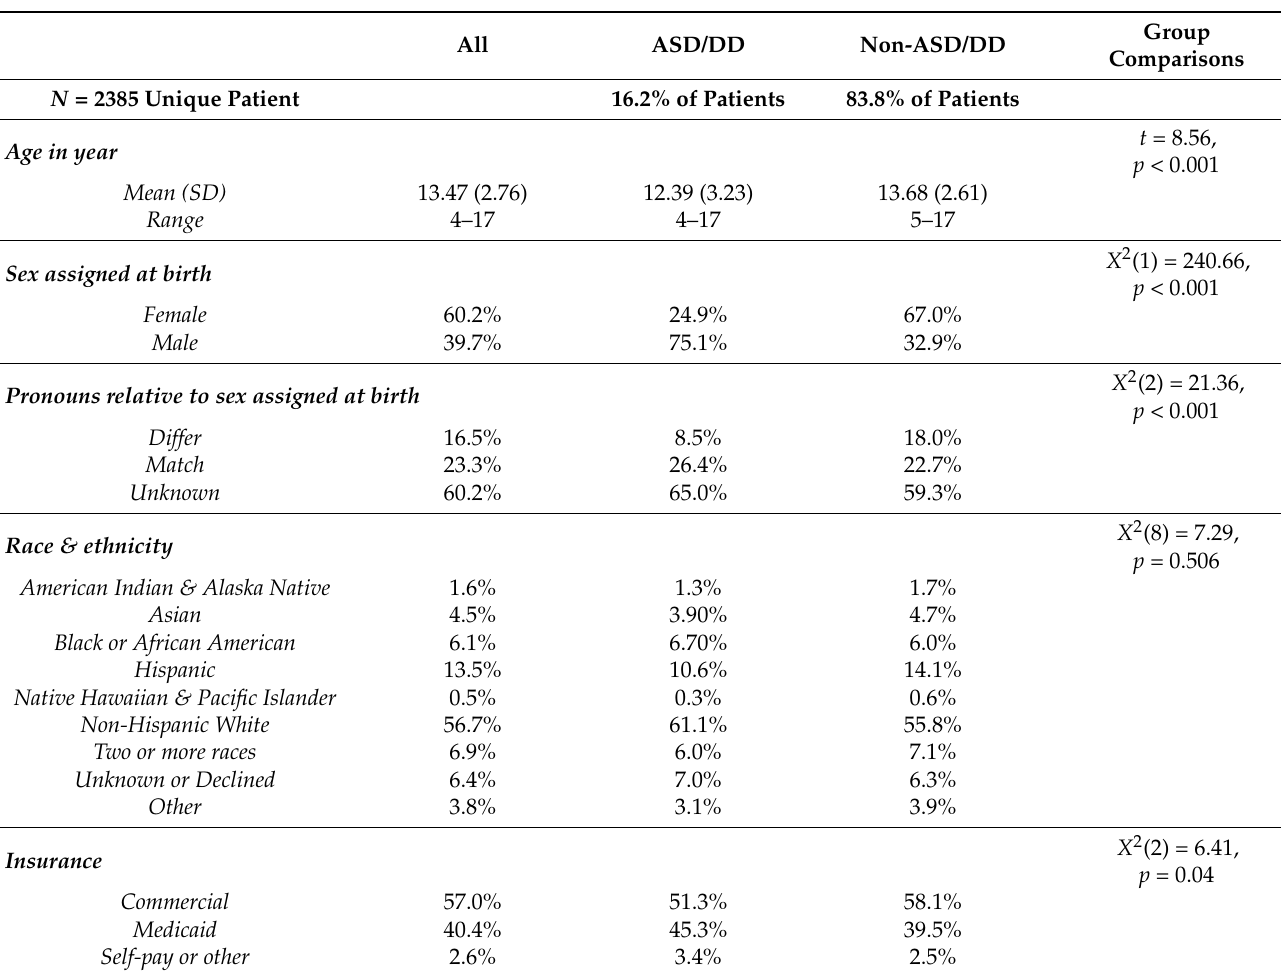
Table 1. Demographic information for PBMU patients with and without ASD/DD during 3-year study